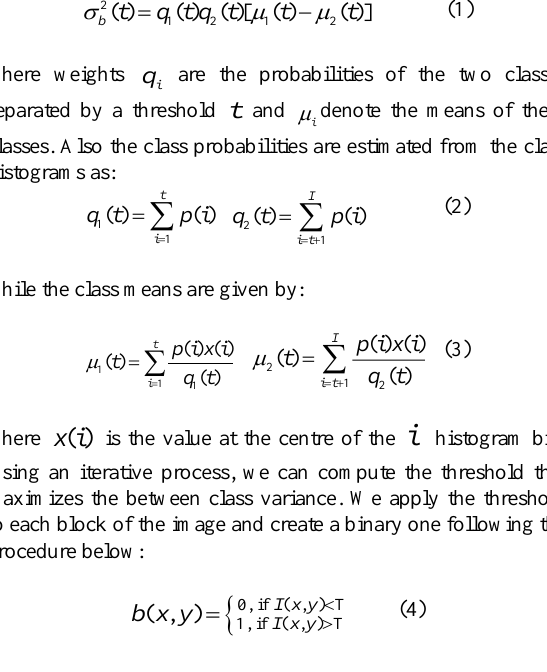
Figure 3. Blocks reflecting various cases of the bimodality procedure: (a) a block that contains mostly sea area, (b) a block that contains coastline area, (c), (d) presents the two Gaussian distributions modelling the distribution of the first and second image, respectively, (e) and (f) reflects the extracted mixture of two Gaussian distributions for the first and second image,